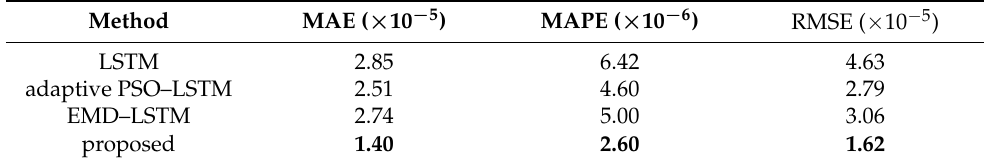
Table 4. Statistical results of roll angle prediction errors in Dataset 1.